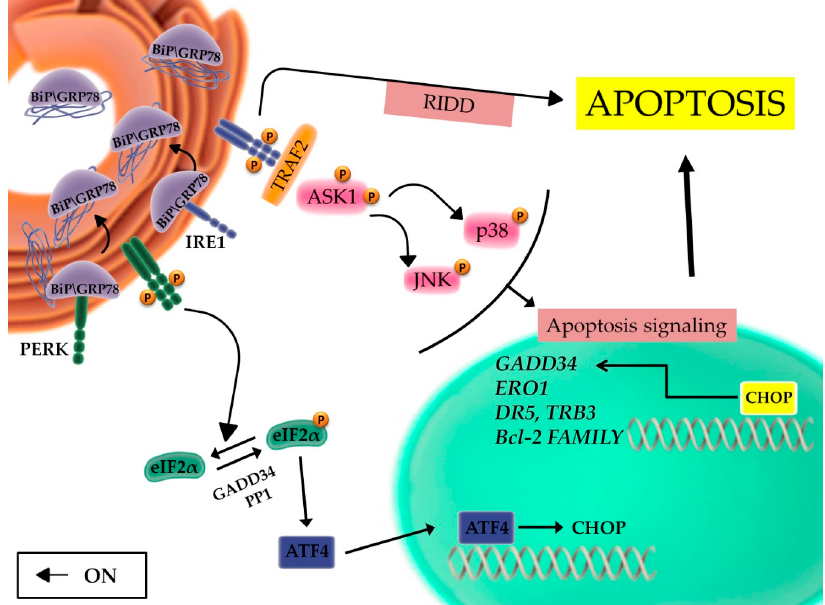
Figure 3. Apoptotic signaling during ER stress. Prolonged or severe ER stress conditions induce apoptotic signaling through the activation of IRE1 and PERK pathways. Upon activation of the IRE1 pathway, IRE1 recruits TRAF2 and ASK1 on the ER membrane and this induces the apoptotic response upon modulation of the balance between proapoptotic and antiapoptotic genes. Furthermore, IRE1 digests specific miRNAs through its endoribonuclease domain (IRE1-dependent decay of mRNA, RIDD). PERK pathway activates ATF4, which in turn enhances the transcription of CHOP, a transcription factor responsible for the regulation of many proapoptotic genes (i.e., GADD34 , ERO1 , DR5 , TRB3 , Bcl-2 family genes). In this complex scenario, GADD34 and PP1 promote the dephosphorylation of eIF2 α , leading to enhanced protein synthesis and the increase of protein load into the ER.